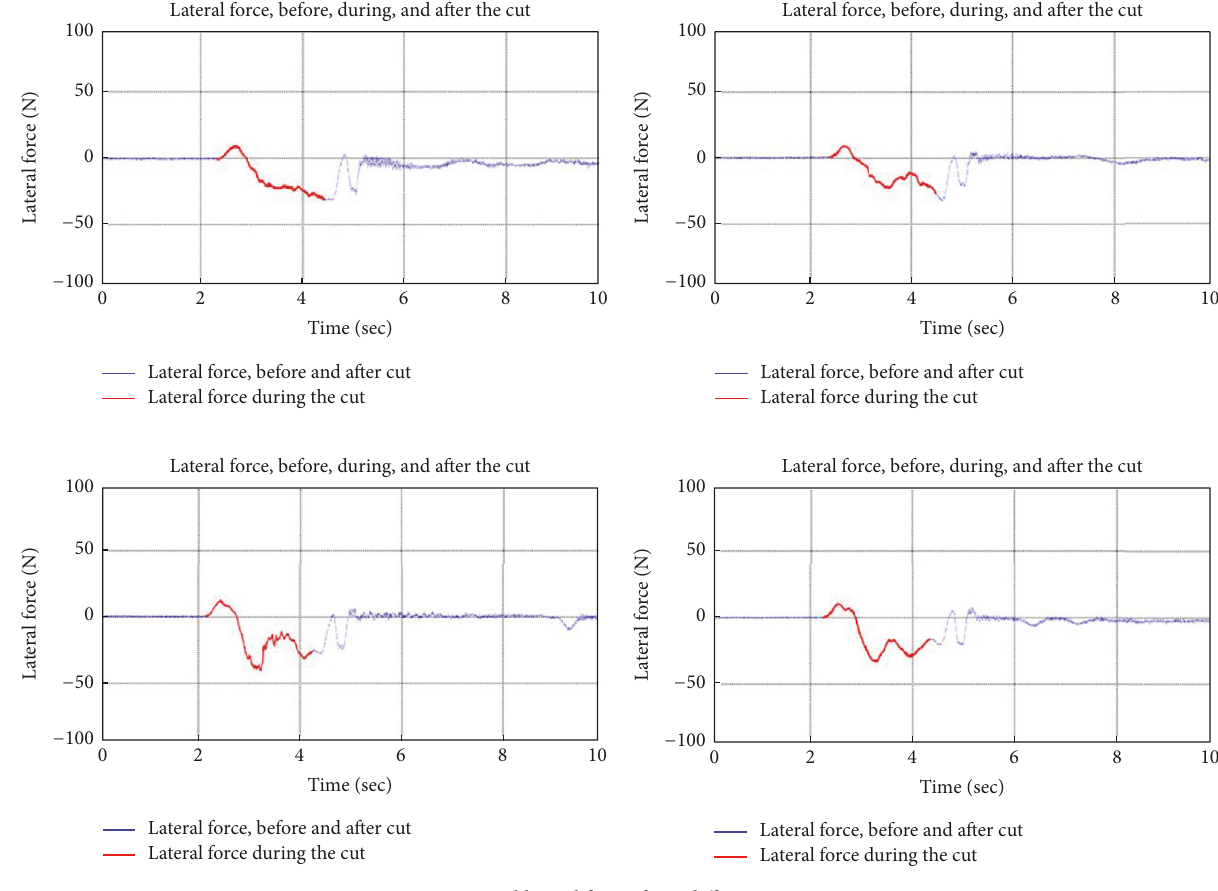
Figure 8: Measured lateral force, for 4 different cuts, 1800rpm.